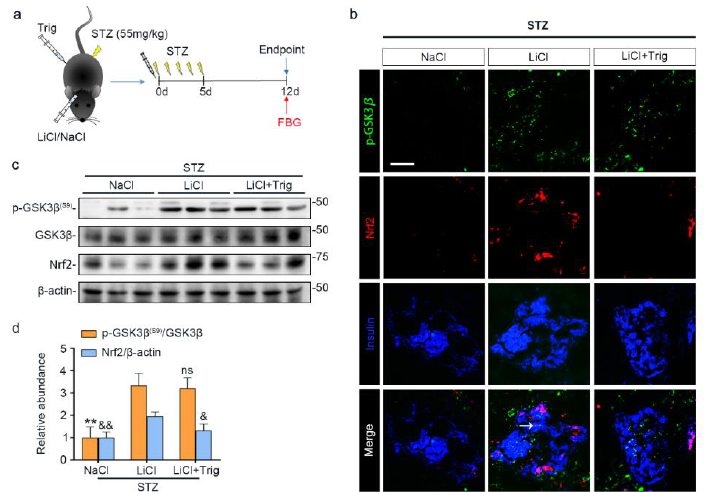
Figure 5. Trigonelline abrogates microdose lithium-reinforced Nrf2 activity in pancreatic islets in STZ-injured mice. Mice received a single injection of lithium chloride, sodium chloride or lithium chloride plus trigonelline (Trig), and then were treated with a daily injection of STZ (55 mg/kg/day) for 5 days. On day 12, fasting blood glucose (FBG) was measured and mice were sacrificed. ( a ) Schematic diagram depicts the animal study design. ( b ) Pancreas cryosections were prepared for fluorescent immunohistochemistry staining for p-GSK3β (green), Nrf2 (red) and insulin (blue). Despite a comparable expression of p-GSK3β in the LiCl group and the LiCl + Trig group, the lithium-promoted Nrf2 expression in β-cells was abolished by Trig treatment, as probed by colocalization of Nrf2 with the β-cell marker insulin (white arrow). Scale bar = 50 μm. ( c ) Representative Western blot analysis of pancreatic islet homogenates for indicated molecules. ( d ) Densitometric quantification of the abundance of p-GSK3β (S9) and Nrf2 in islets, presented as relative levels normalized to GSK3β and β-actin respectively. Data were expressed as fold changes over NaCl group and presented as mean ± SD; ** p < 0.01 versus LiCl; ns: not significant versus LiCl; & p < 0.05, && p < 0.01 versus LiCl ( n = 5). Abbreviations: GSK3β, glycogen synthase kinase 3β; Nrf2, nuclear factor erythroid 2-related factor 2; p-GSK3β, phosphorylated GSK3β at serine 9; p-GSK3β (S9) , phosphorylated GSK3β at serine 9.